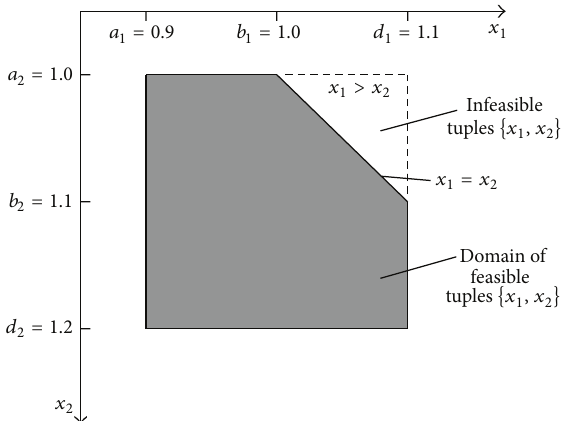
Figure 12: Domain of feasible tuples of weight values {𝑥 1 ,𝑥 2 } which can take part in adding of fuzzy numbers 𝑥 1 and 𝑥 2